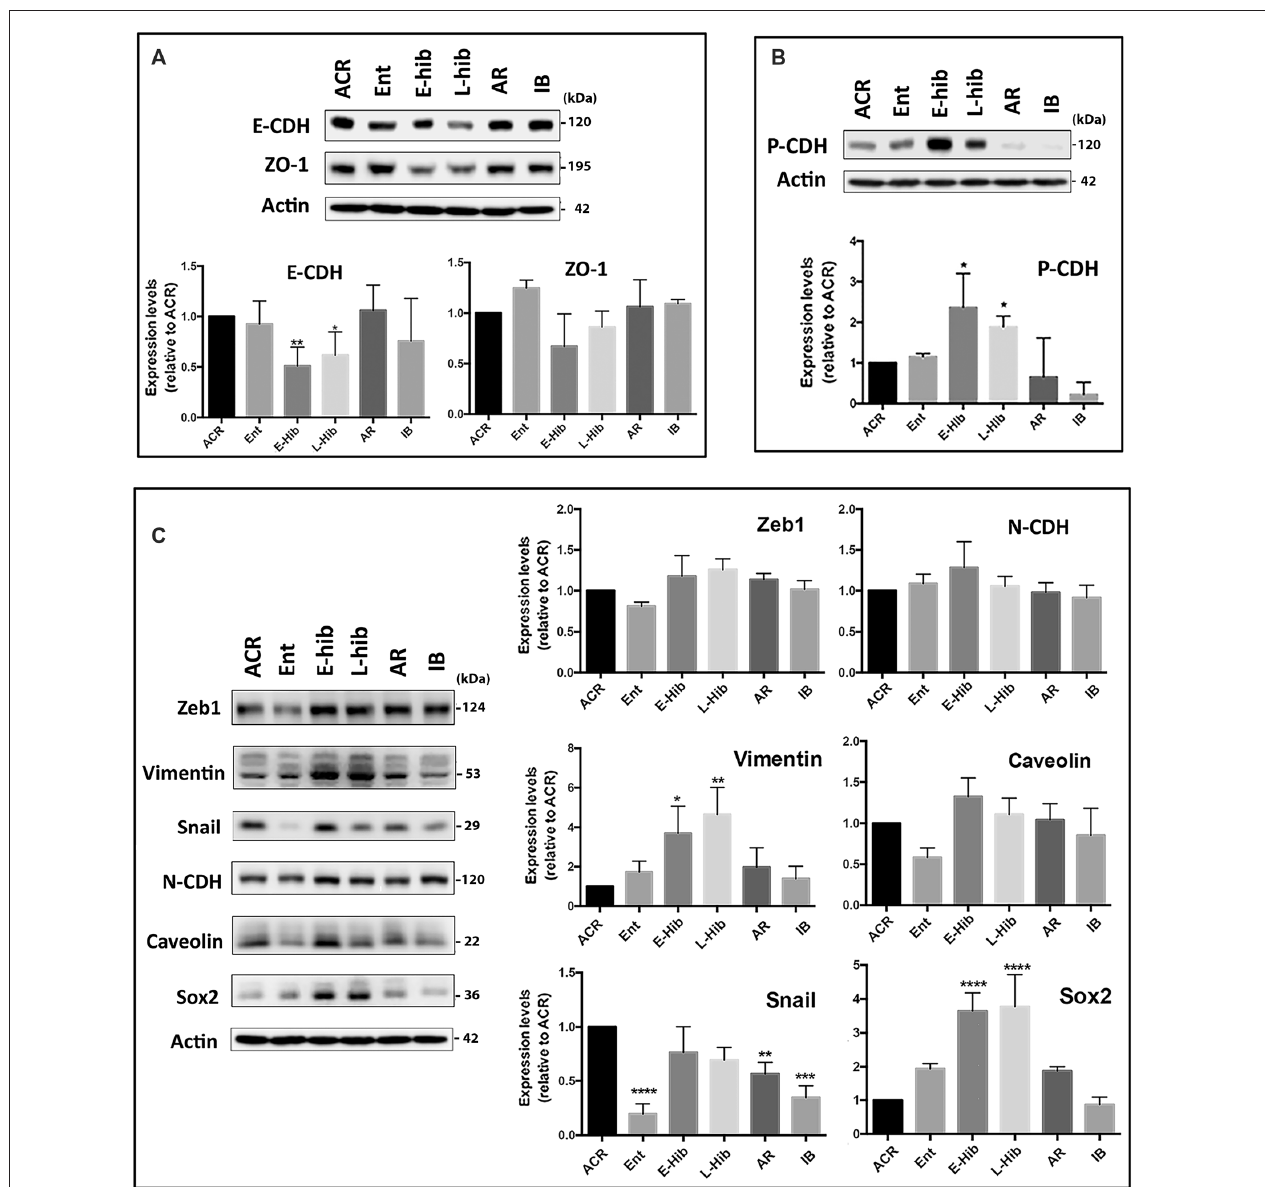
FIGURE 2 | Expression levels of epithelial–mesenchymal transition (EMT)-related proteins in squirrel brains during hibernation bouts. (A) Representative immunoblots of epithelial markers E-cadherin (E-CDH) and ZO-1 in brain extracts from various stages of hibernation (upper panel), and their quantitative analyses (lower panel). (B) An intermediate (partial) EMT marker, P-cadherin (P-CDH), was differentially expressed in squirrel brains during hibernation bouts. Representative immunoblot (upper) and its quantitation (lower). (C) Representative immunoblots of several mesenchymal markers in the brain extracts from various stages of hibernation bout (upper) and their quantitative analyses (lower). ACR, active in cold room; Ent, entrance; E-hib, early torpor; L-hib, late torpor; AR, arousal; IB, interbout. Data represent the mean ± SD of at least four different brain samples from each stage of hibernation bout. The statistical analyses were shown relative to the ACR